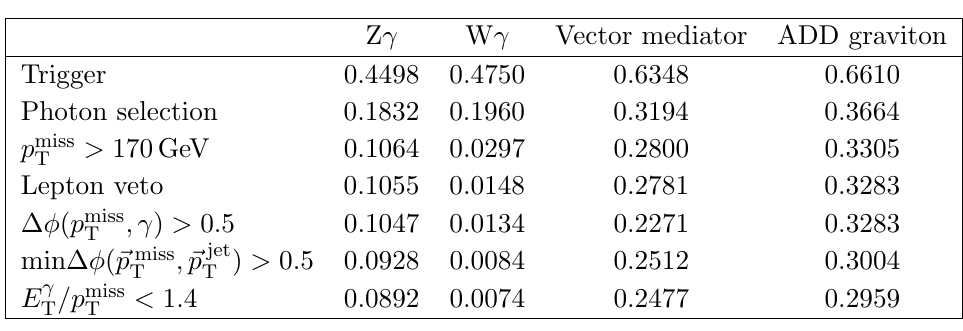
Table 4 . Step-by-step e(cid:14)ciencies of various selections for irreducible Z (cid:13) and W (cid:13) processes as well as two representative signal models: a 1 TeV vector mediator decaying to 1 GeV DM particles and an ADD graviton model with 8 extra dimensions and M D = 3 TeV. The statistical uncertainties on these values are generally on the order of half a